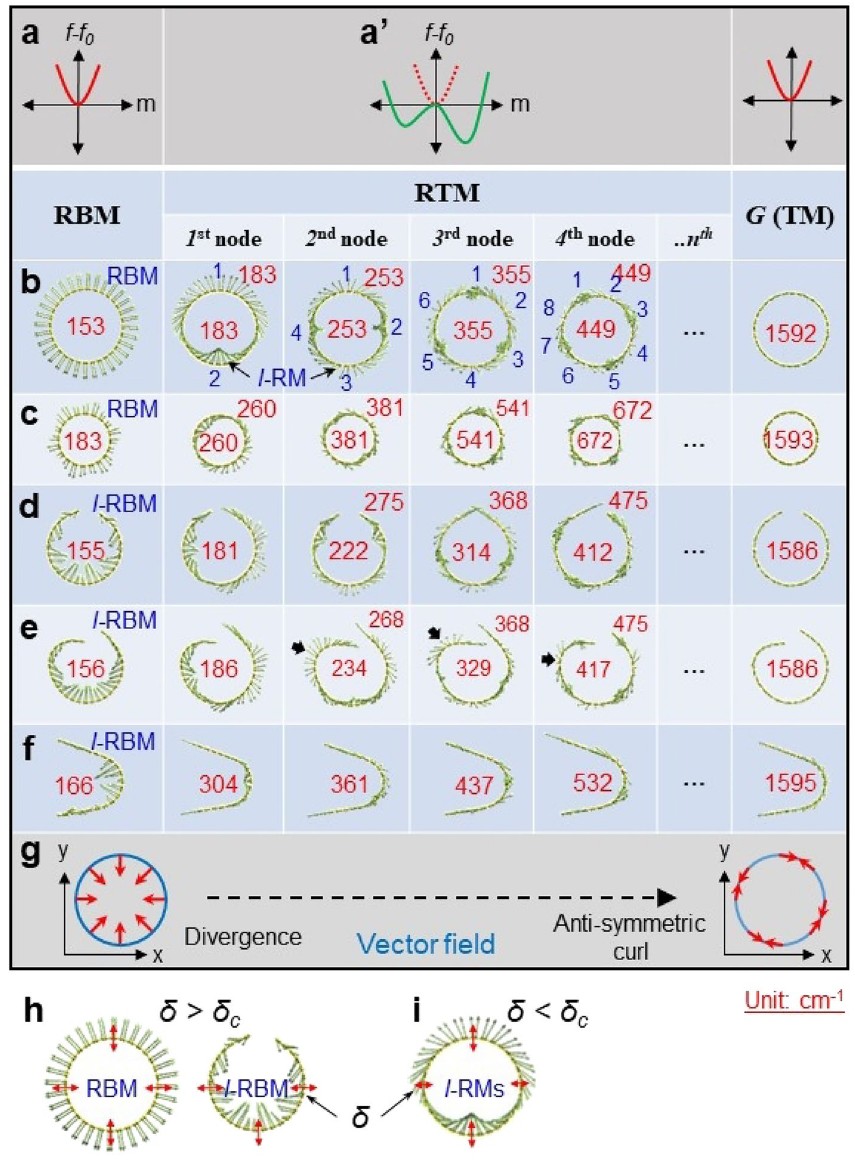
Figure 3. Simulated Raman-active modes for different graphene structures. ( a , a ’) Landau free energy landscape with one ( a ) or two minima ( a ’), which are the conditions of RBM ( l -RBM) and G -mode or RTMs, respectively. ( b – f ), Raman modes simulated from concentric tubes of ~ 2.2 nm ( b ) and 1.4 nm ( c ) in diameter, opened tubes ( d , e ) and curved graphene ( f ), revealing RBM (or l -RBM), RTM and G -mode in order. We used the opened tubes instead of helical structures. The blue numbers represent the number of nodes for each RTM. The red numbers in ( b – f ) represent the frequencies of the modes. ( g ) Diagrams explaining divergence and anti-symmetric curl of vector fields. ( h , i ) Schematic explaining Landau condition for RBM ( δ > δ c ) ( h ) and RTM ( δ < δ c ) ( i